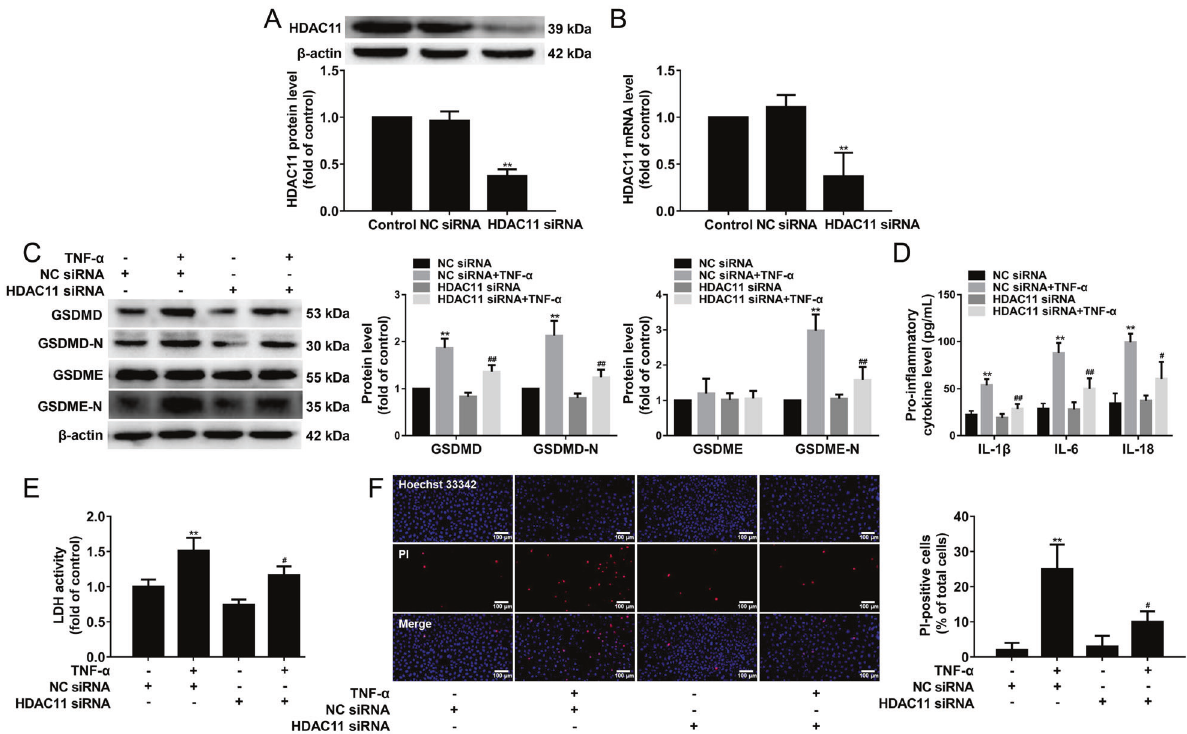
Fig. 4 HDAC11 knockdown inhibits pyroptosis in TNF- α -induced HUVECs. A , B HUVECs were transfected with HDAC11 siRNA or NC siRNA for 48 h, and then the protein and mRNA expressions of HDAC11 were determined by western blotting and quantitative real-time PCR. HUVECs were stimulated with 40 ng/mL TNF- α for 12 h after their transfection with HDAC11 siRNA or NC siRNA. C The protein expressions of GSDMD, GSDMD-N, GSDME, and GSDME-N were determined by Western blotting. D The levels of IL-1 β , IL-6, and IL-18 in the cellular supernatant were detected by ELISA assay. E The cellular supernatant LDH level was evaluated with a cytotoxicity detection LDH kit. F The representative photographs of double- fl uorescent staining with PI (red) and Hoechst 33342 (blue), and the quanti fi cation of PI-positive cells, ×200. Scale bar indicates 100 μ m. ** P < 0.01, vs. NC siRNA group; # P < 0.05, ## P < 0.01 vs. NC siRNA + TNF- α group. Results are expressed as mean ± SD ( n =